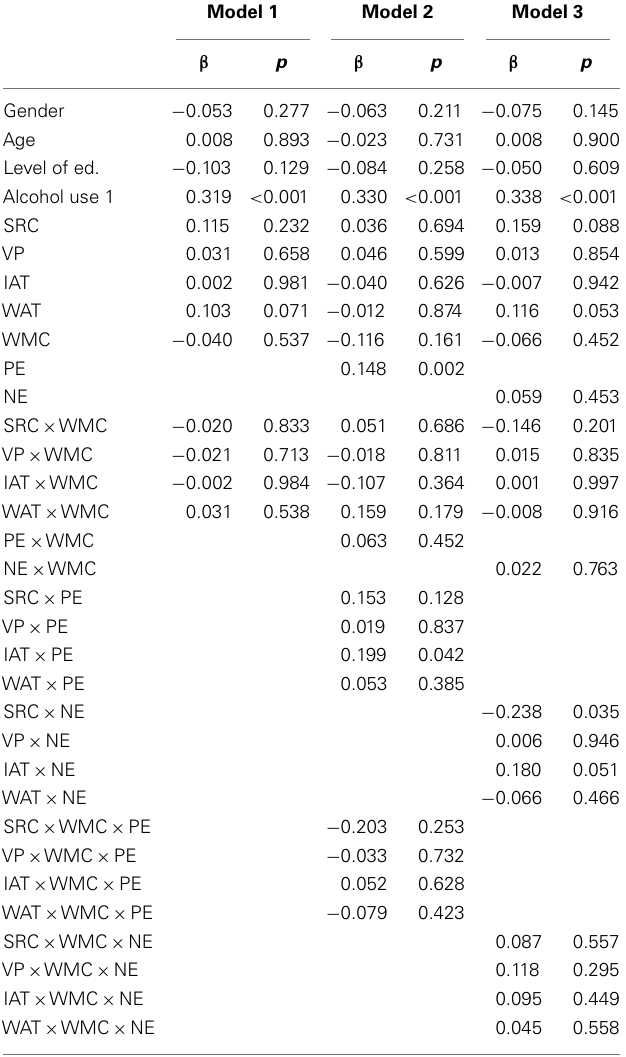
Table 2 | Results